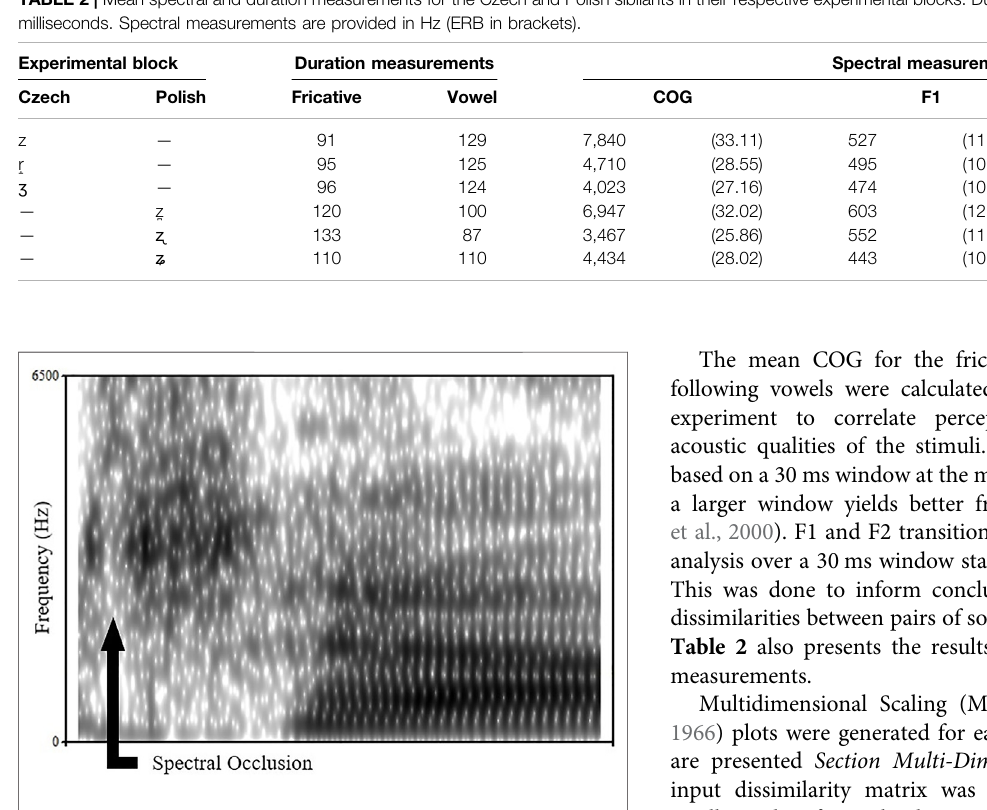
FIGURE 1 | Spectrogram for the female participant ’ s articulation of /r ̝ /. The arrow indicates the presence of a spectral occlusion for a tongue-palate contact during